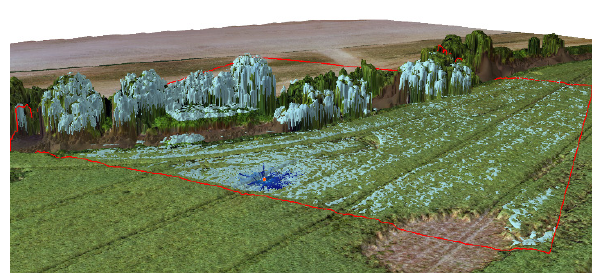
Figure 7. 3D visualization of extended viewshed - angle difference to the local